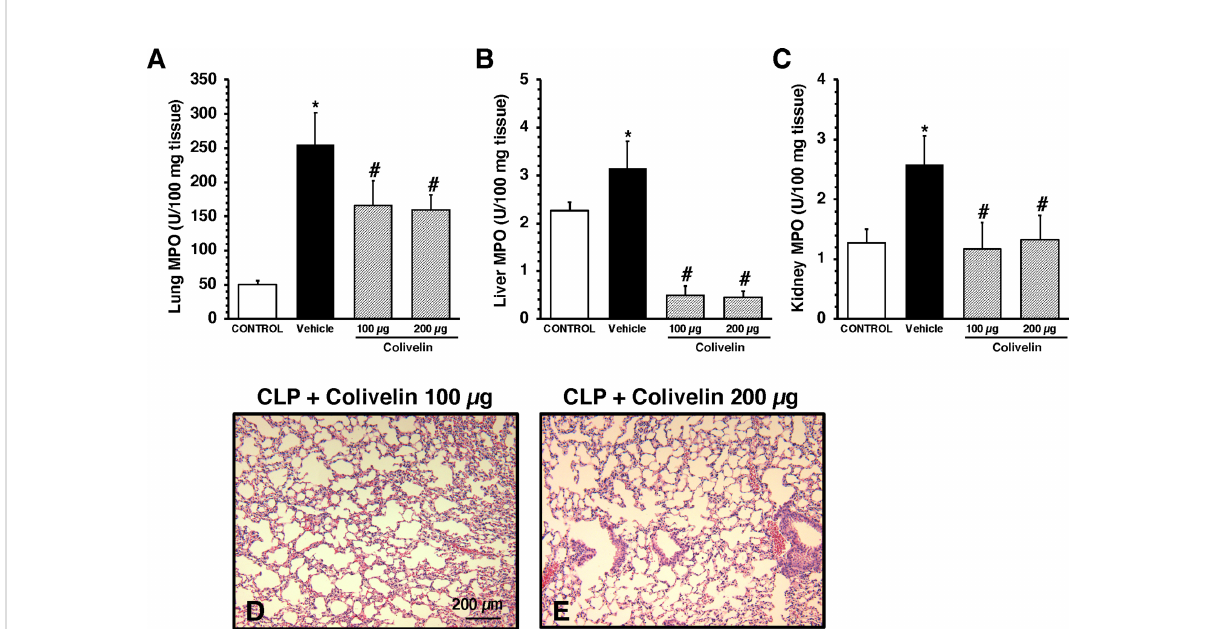
FIGURE 3 Activity of myeloperoxidase (MPO) in lung (A) , liver (B) , kidney (C) at 6 h after cecal ligation and puncture (CLP). Data represents the mean ± SEM of 7-17 mice for group (n=17 control group, n=13 vehicle group, n=7 colivelin 100 µg group, n=11 colivelin 200 µg group). *Represents P < 0.05 versus control mice; #represents P < 0.05 versus vehicle-treated mice. (D-E) Representative histology photomicrographs of lung sections of colivelin-treated mice at 6 h after CLP. Vehicle (200 µl distilled water) or colivelin (100 or 200 µg/kg) was administered intraperitoneally at 1 h after CLP. Magni fi cation x100. A similar pattern was seen in tissue sections of n=5 mice in each experimental